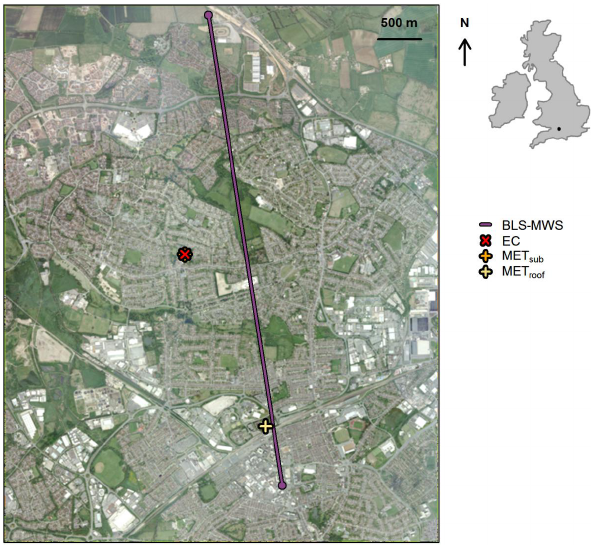
Figure 1. Aerial photograph (2009, GeoPerspectives © ) of the study area showing the locations of the two-wavelength scintillometer path (BLS–MWS), eddy covariance station (EC) and two mete- orological stations (MET sub , MET roof ). The location of Swindon within the British Isles is shown (top right